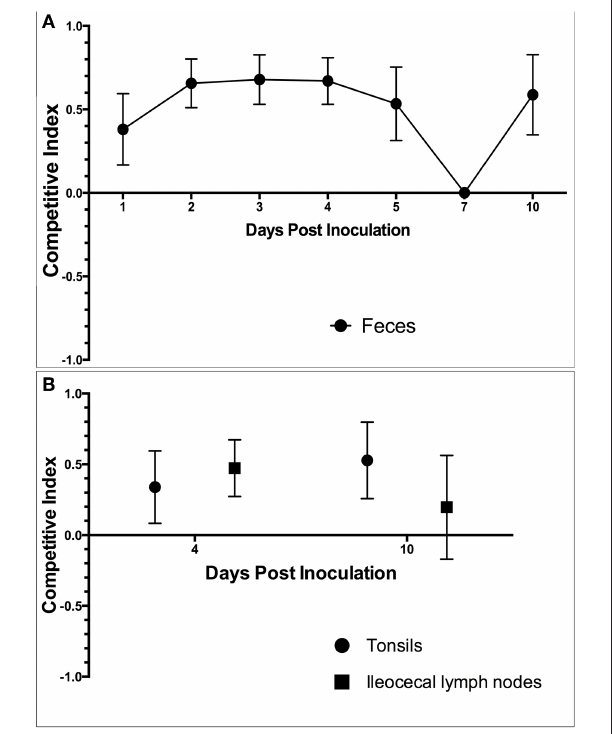
FIGURE 11 | The competition index (CI) calculated based on the culture results from animal study #3. The CI was calculated for (A) fecal samples collected throughout the study period and (B) samples collected at the time of necropsy on DPI 4 and 10. The CI represents the fitness of Salmonella 4,[5],12:i:- relative to Salmonella Typhimurium, with a positive CI indicating that S. 4,[5],12:i:- is more fit within the host and a negative CI indicating that S. Typhimurium is more fit within the host. Values closer to 1 or − 1 indicates that 4,[5],12:i:- or Typhimurium were the dominant Salmonella serovar in that set of samples,